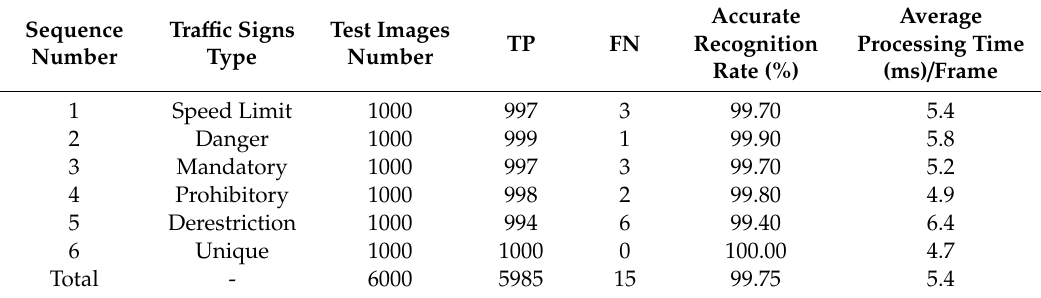
Table 3. The classification and recognition test results of six categories of tra ffi c signs.